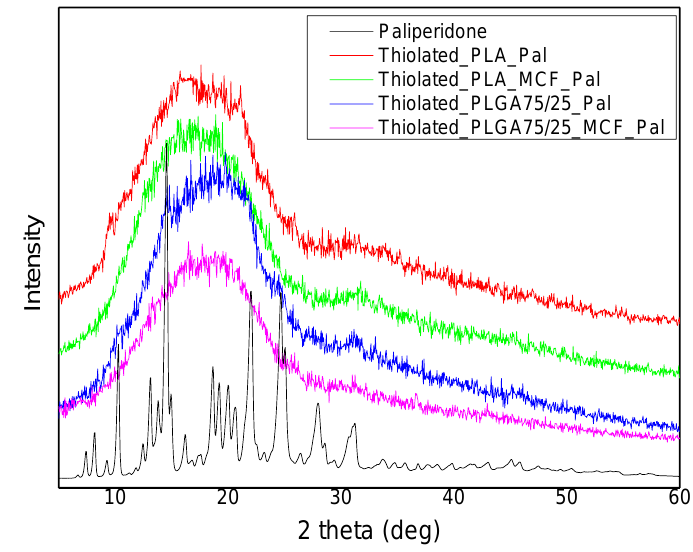
Figure 8. XRD patterns of thiolated microspheres loaded with paliperidone.